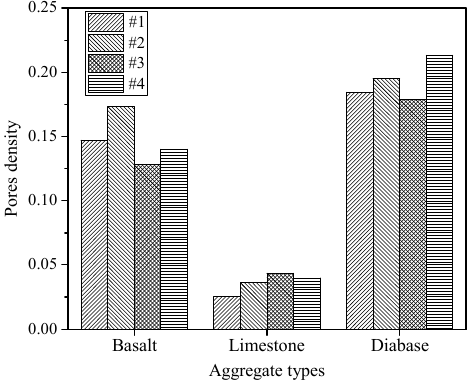
ff erent interfacial